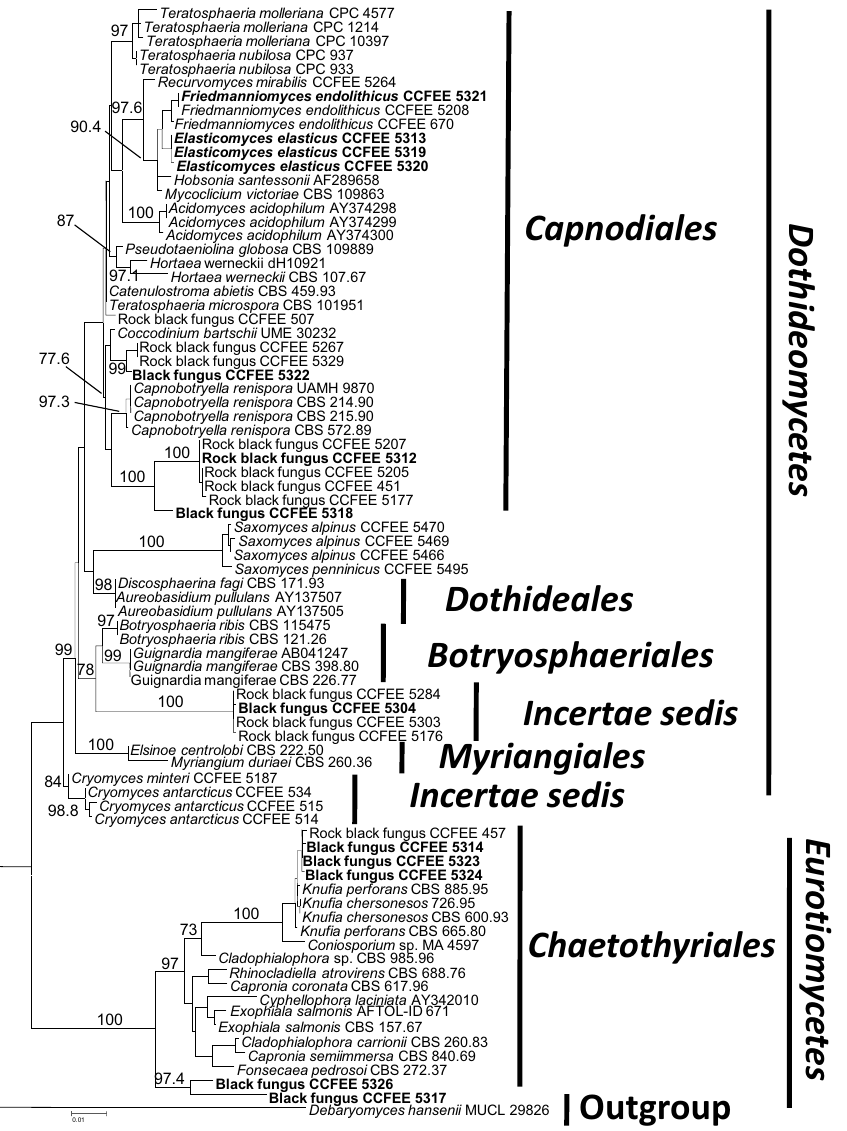
Figure 3. SSU ML tree indicating the phylogenetic position of the black meristematic fungi isolated from lichens (reported in bold in the tree). The strains reported as Rock black fungus are still unidentified rock fungi deposited in the Culture Collection of Fungi From Extreme Environments. Bootstrap values are the results of 1,000 pseudoreplicates. Values below 70 are not